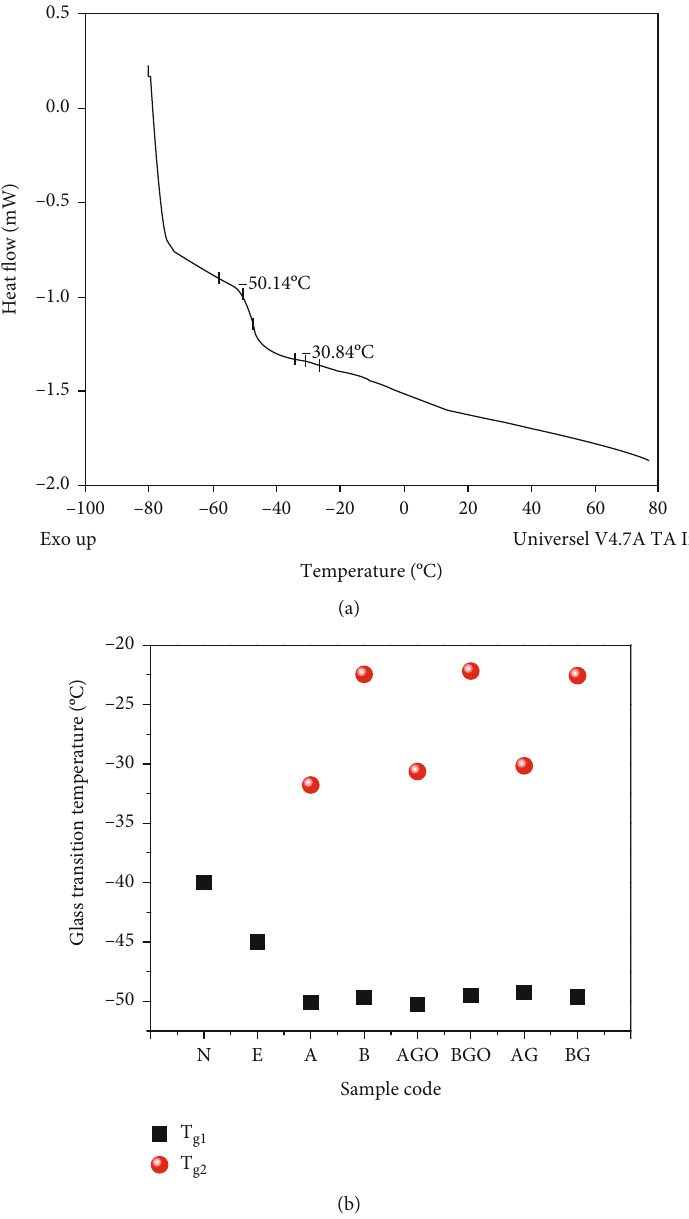
Figure 4: Glass transition temperatures ( T samples of un fi lled and fi lled